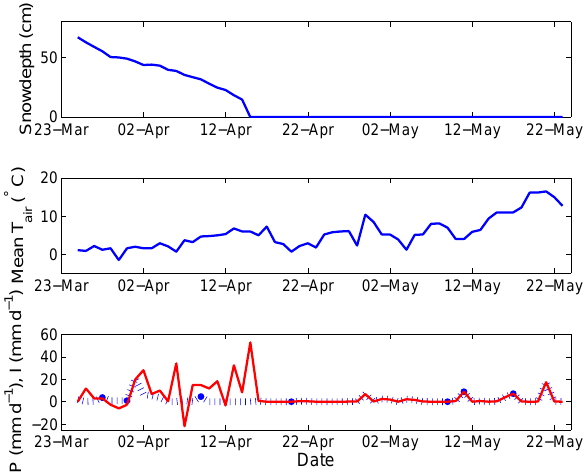
Fig. 2. Weather series for the snowmelt experiment (in 2010), mean T air is the daily mean temperature ( ◦ C ), P is the daily precipitation ( mmd − 1 , dotted blue line), I is the infiltration ( mmd − 1 , red line). The daily infiltration is calculated from the sum of the change in the equivalent water depth of the snow cover in a day, and the precipitation.